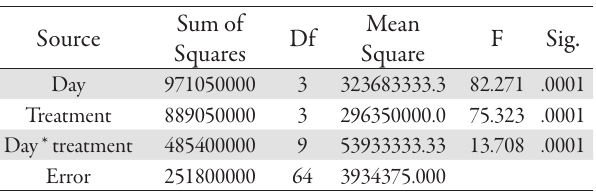
Tab. 1. ANOVA showing effect of day, media treatment and day × media interaction Sum of Source